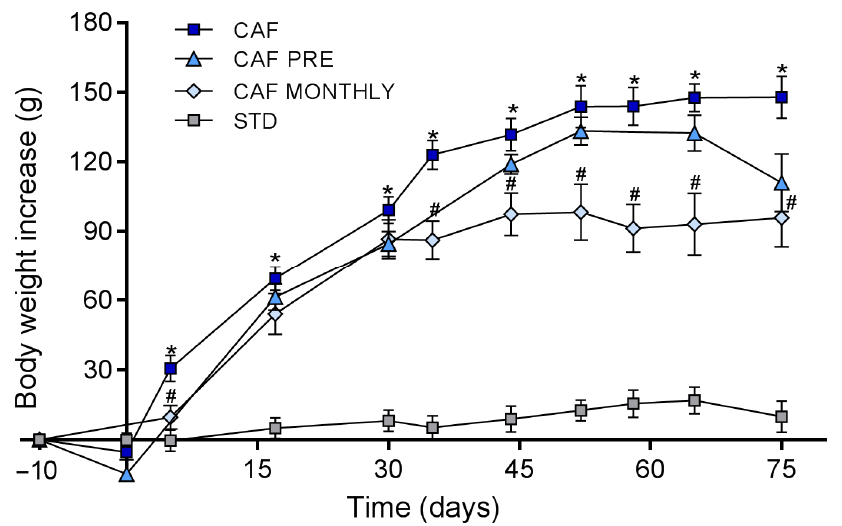
Figure 2. Body weight gain during the experiment. STD: lean rats fed a standard diet; CAF: rats fed a cafeteria diet; CAF PRE: rats receiving preventive treatment of GSPE during 10 days before cafeteria diet intervention; CAF MONTHLY: rats receiving GSPE treatment during 5 days once per month simultaneously fed with cafeteria diet. Values are means ± SEM. * p -value < 0.05 compared to STD rats. # p -value < 0.05 compared to CAF rats.